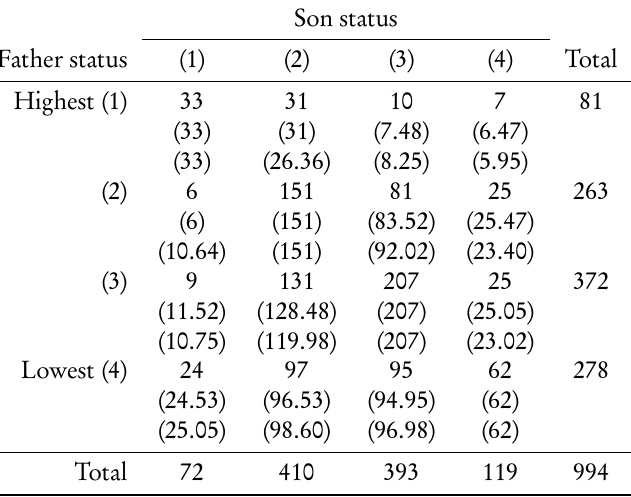
The maximum likelihood estimates of expected frequencies under the columns-parameter symmetry (CPS) and polynomial columns-parameter symmetry (PCPS) with ∆ set in Table 1 are shown in parentheses in the second and third lines,